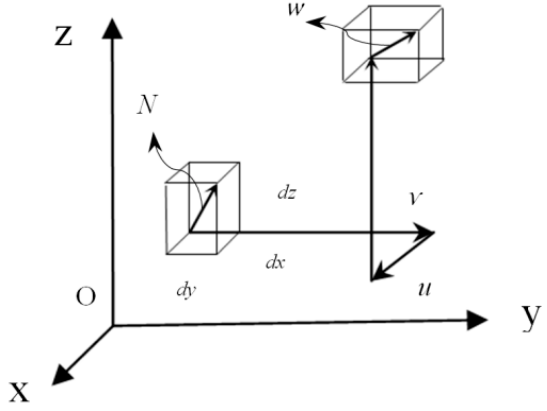
Figure 3. The overall contribution of the displacement.